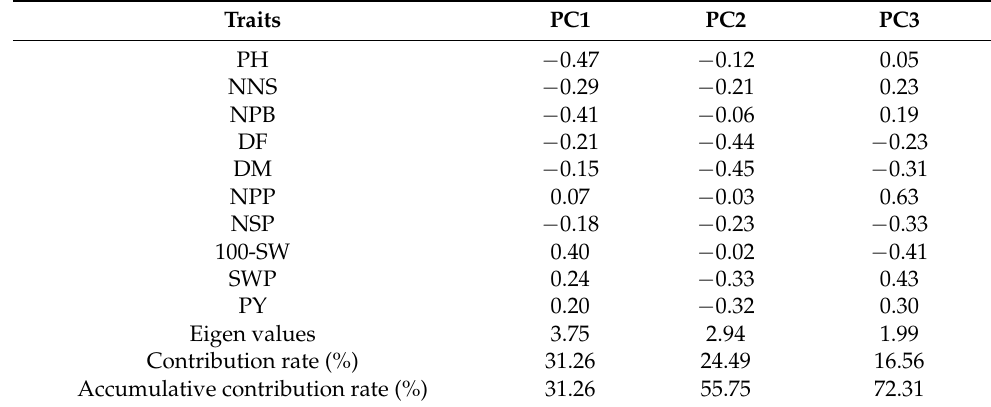
Table 4. Trait contributions, eigenvalues, and cumulative percentage of the components.